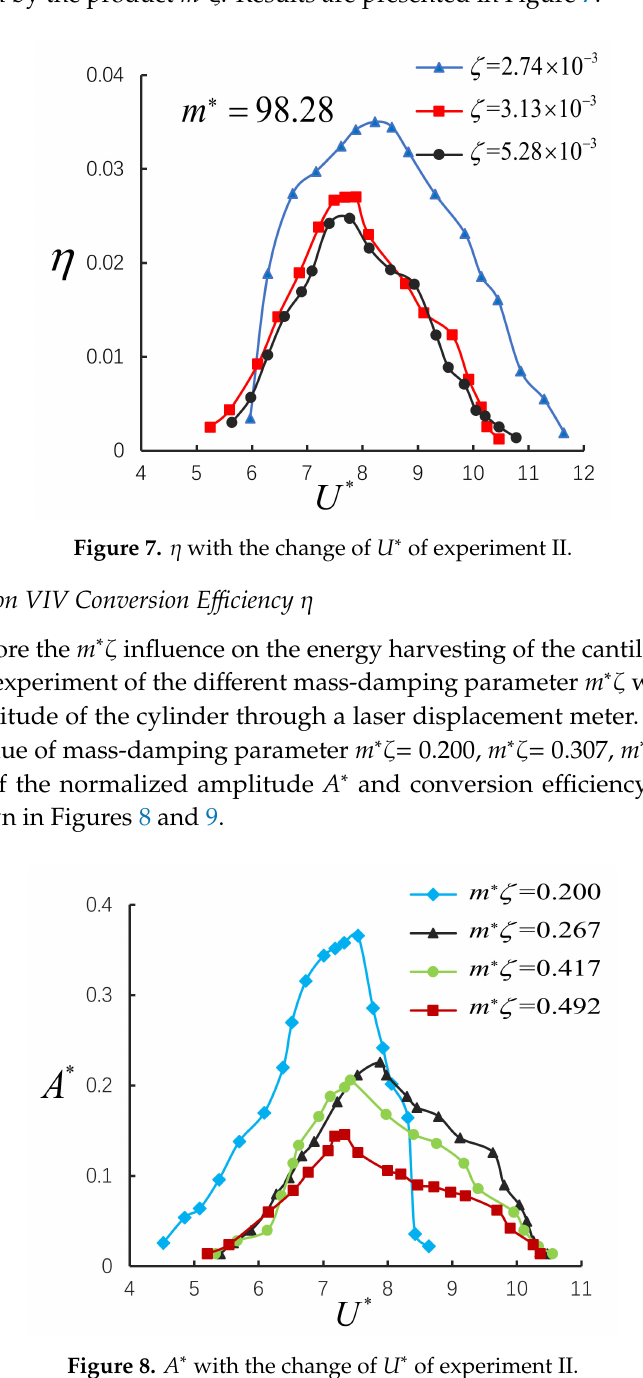
Figure 8. A ∗ with the change of U ∗ of experiment